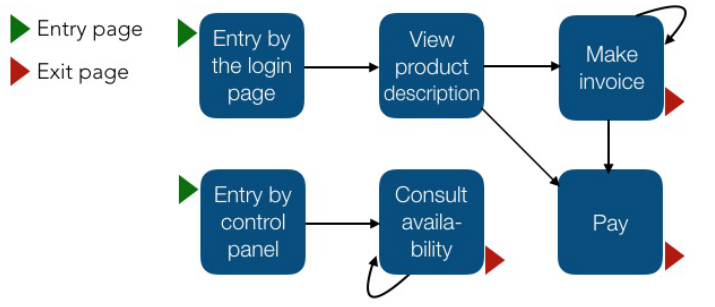
Figure 3. An example of sessions represented with rules. Each node represents a rule (business functions) that groups N web pages. We can see, for example, that visitors who arrive at the website by the login page have a greater chance of paying than those who enter through the control panel. We also identify loops. The loop in the “Consult availability” rule may be expected because visitors usually review the availability of N products. However, the loop in the “Make invoice” is worth investigating since it could be a cause of